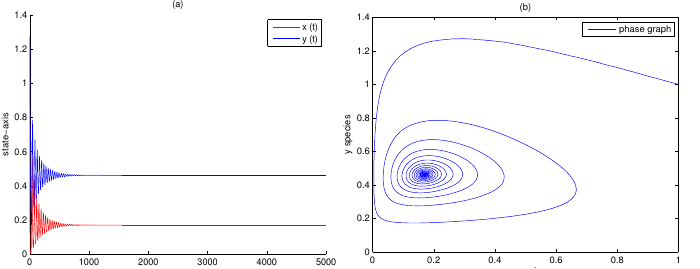
Figure 9. The global stability of E ∗ ( x ∗ , y ∗ ) of (4) with σ 1 = σ 2 = 0.02: ( a ) time-series curves of x ( t ) and y ( t ) and ( b ) phase diagram.